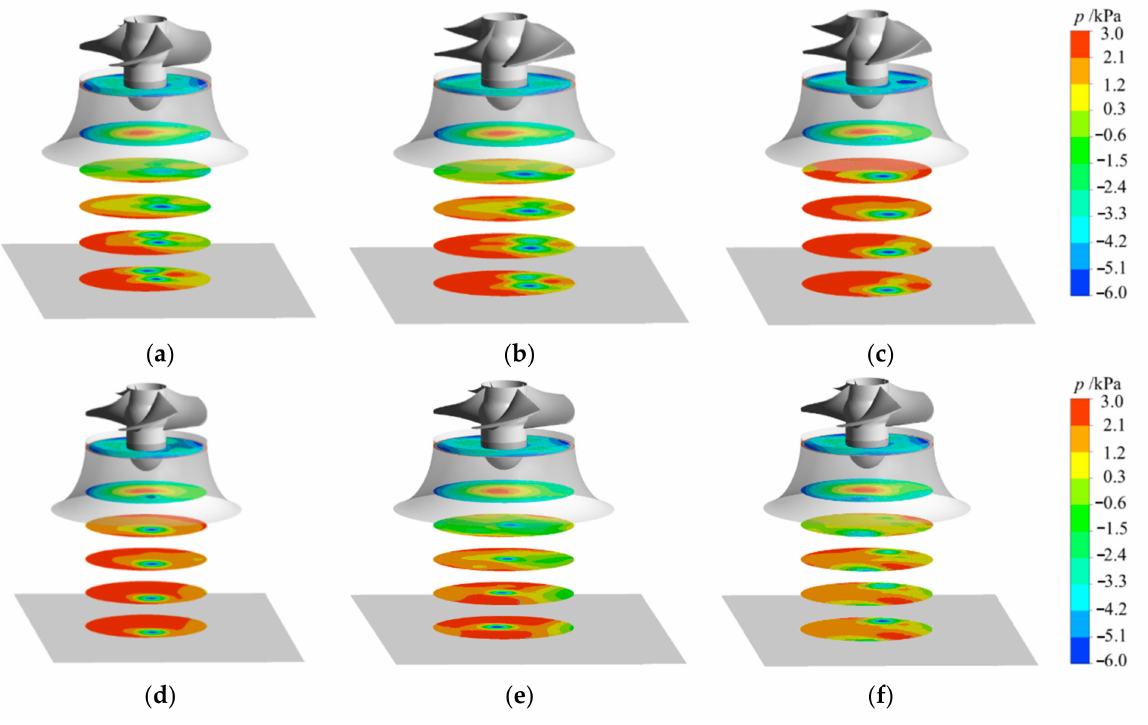
Figure 9. Pressure distribution at different moments and positions. ( a ) t 0 = 1.03 s, ( b ) t 1 = 1.33 s, ( c ) t 2 = 1.63 s, ( d ) t 3 = 1.98 s, ( e ) t 4 = 2.14 s, and ( f ) t 4 = 2.38